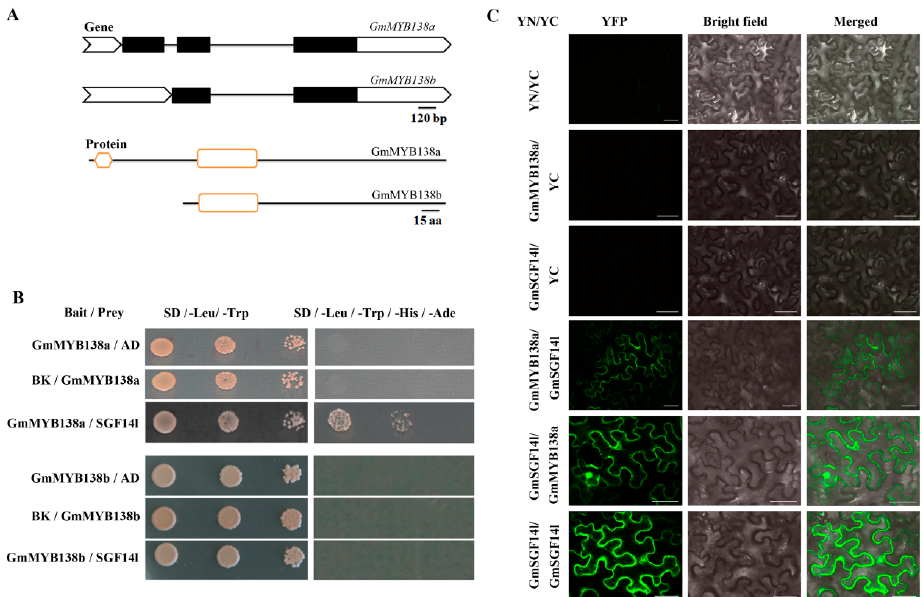
Figure 4. Interaction of GmMYB138a with GmSGF14l. ( A ) Schematic diagram for two spliced transcripts of Glyma.02g026300 (GmMYB138a and GmMYB138b) at protein and gene levels. Black lines represent the introns, while black boxes refer to the exons of two spliced transcripts in the gene structures. In the protein structures, amino acids are indicated by black line. MYB domain is marked with rectangle, while sexangle refer to ZnF_C2HC domain; ( B ) The investigation of interaction between GmSGF14l and GmMYB138a/b using yeast two-hybrid assay. Yeast cells were co-transformed with combination of DNA-binding domain (BK, Bait) and activation domain (AD, Prey) fused constructs as indicated. A series of 5 µL of diluted yeast suspension culture co-transformed with bait and prey constructs was spotted onto synthetic defined (SD) selection plates. Growth on SD/-Leu/-Trp indicates the presence of both the vectors, while growth on SD/-Leu/-Trp/-His/-Ade shows interaction between prey and bait. The different combinations with GmMYB138a or GmMYB138b/BK or AD are negative controls; ( C ) The BiFC assay showing interaction between GmYB138a and GmSGF14l. Tobacco leaves were co-transformed with GmYB138a and GmSGF14l proteins fused to the N- or C-terminal half of yellow fluorescent protein followed by confocal microscopy. Scale bar is shown in 40 µ